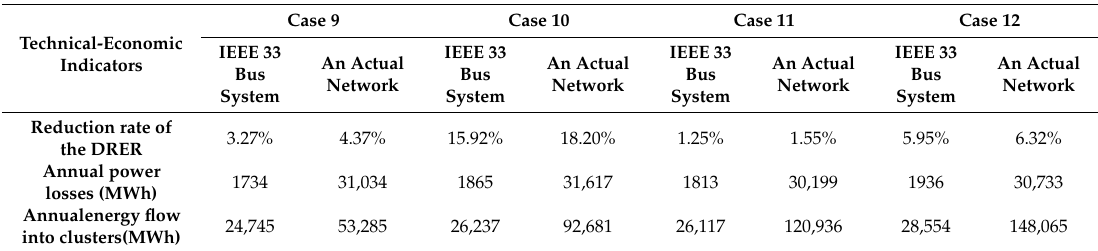
Table 8. Comparison of planning results for di ff erent